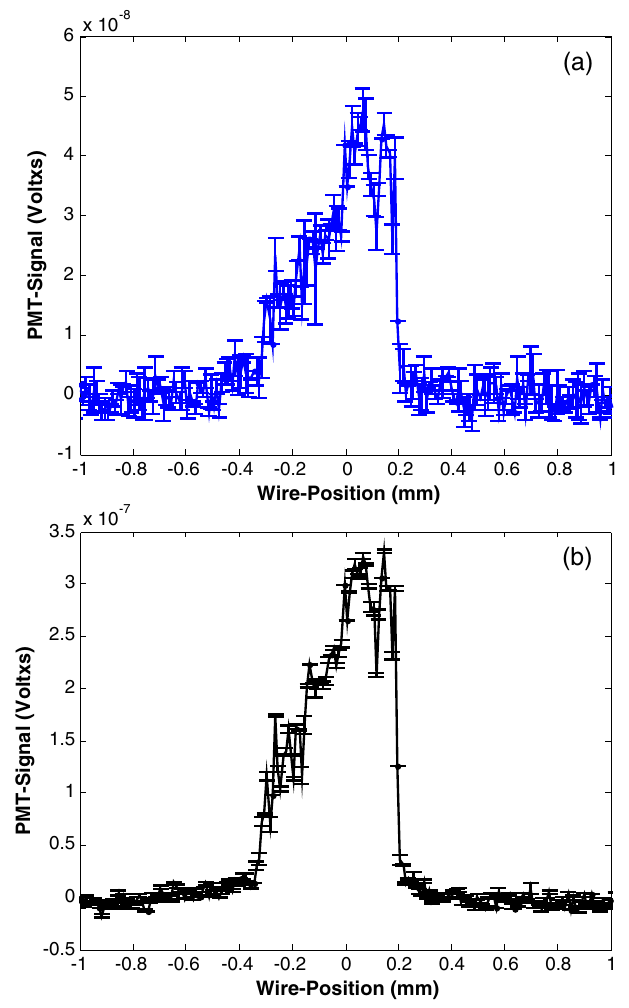
FIG. 12. Beam profile of a 10 pC beam — and energy 200 MeV — scanned by a 5 μ m tungsten wire as reconstructed by the signal readout of (a) BLM2 and (b) BLM3 at a distance of 2.3 and 3.5 m from the WSC,